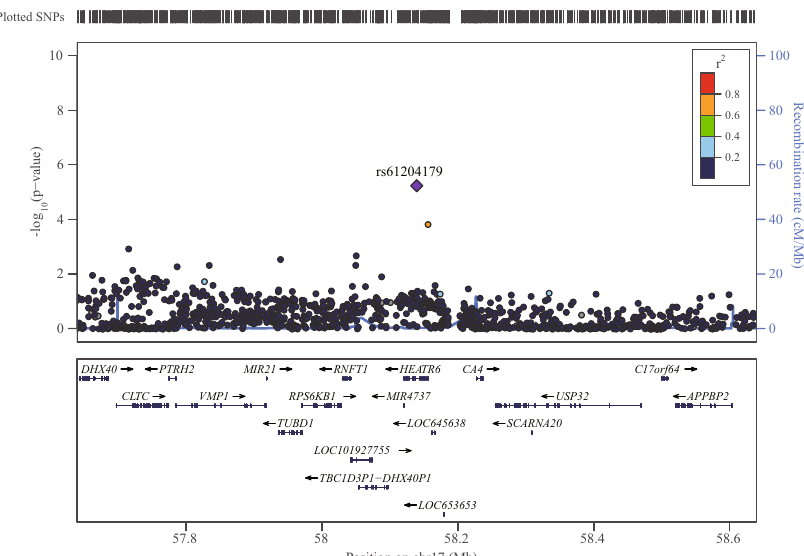
Fig. 4 Regional plot of the rs61204179. Regional plot of the association signal of rs61204179 by LocusZoom. Reference data of Asian population from 1000 Genomes were used for linkage disequilibrium calculation.